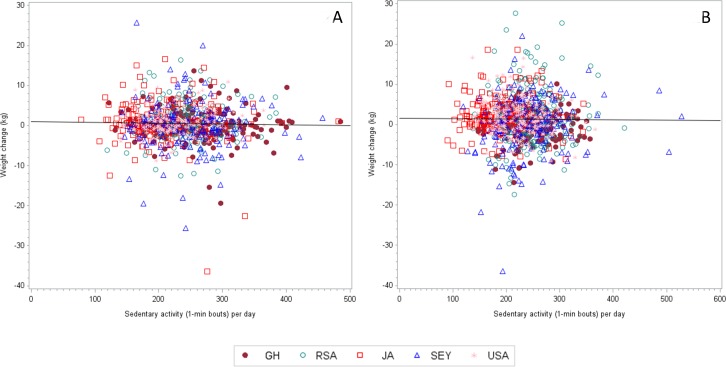
The correlation coefficient (adjusted for age and follow up time) between weight change and MVPA (1-min bouts) for women is 0.05997 (n = 1, 027, p = 0.0549).